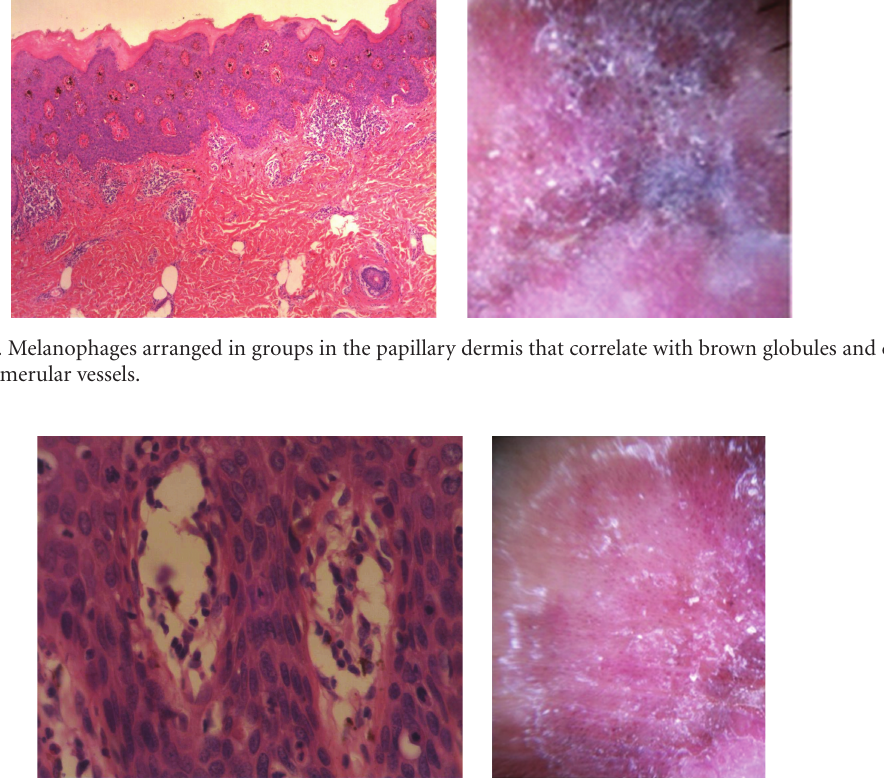
Figure 15: Case 2. H&E. Closeup of dilated capillary vessels in the papillary dermis enclosed by the marked acanthosis that correlates with glomerular vessels.